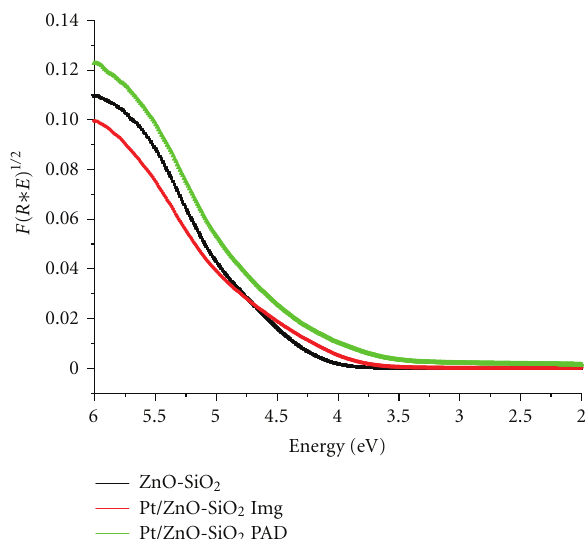
Figure 7: Bandgap calculated from the DR-UV-Vis spectra of ZnO- SiO 2 , Img: Pt-ZnO-SiO 2 , and PAD: Pt-ZnO-SiO 2 .